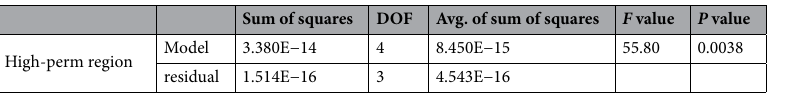
Sum of squares DOF Avg. of sum of squares F value P